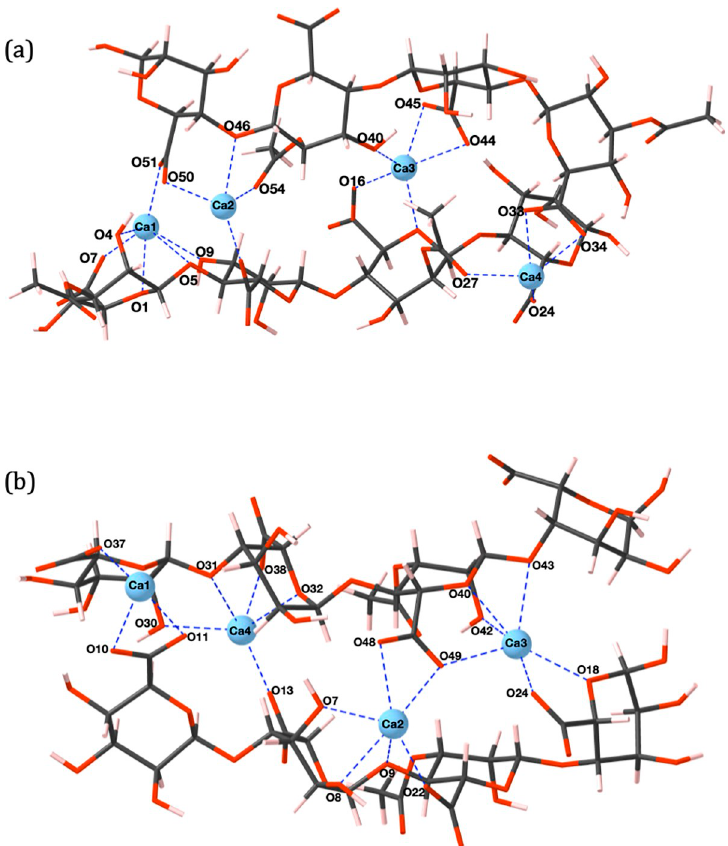
Fig 3. (a) PolyM (ap) (b) PolyMG (p) 2-chain calcium complexes. Carbon atoms are shown in grey, oxygen in red, calcium in blue and hydrogen in pink. Oxygen atoms and cations involved in ionic bonding are labelled and the cation-oxygen bonds are shown with dashed blue